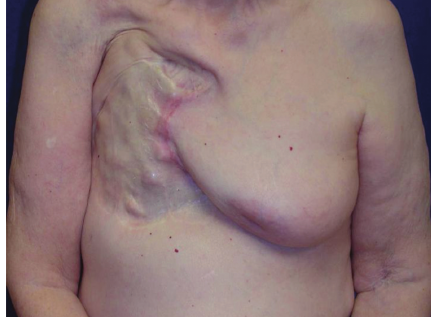
Figure 1: An 80-year-old woman with local chest wall recurrence of breast cancer 52 years after Halsted mastectomy.